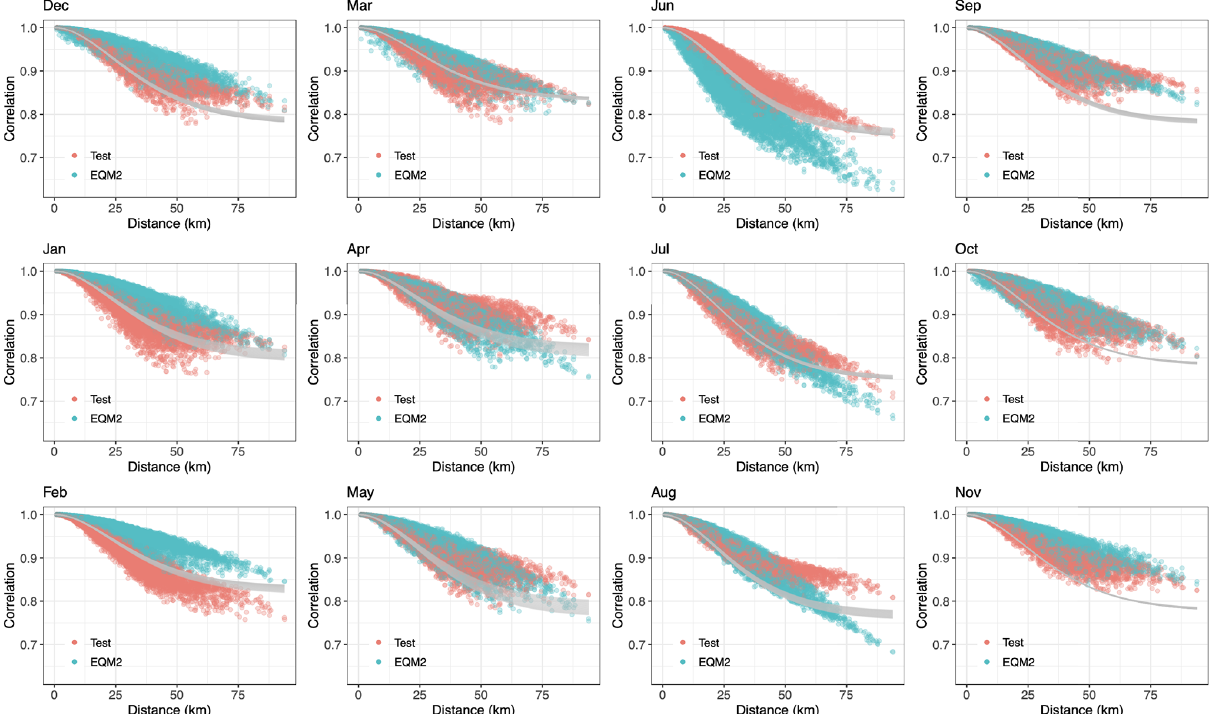
Figure 6. Empirical spatial correlation of precipitation amount at the catchment Gaulfoss for each month of the year. Results are shown for the seNorge data in the test period 1987–2005 (red dots) and for the EQM simulation based on RCM2 (cyan dots). The Matérn spatial correlation estimated with the WG method based on seNorge data in the training period 1957–1986 is indicated in grey, with the width of the bar indicating the spread of the daily estimates within the